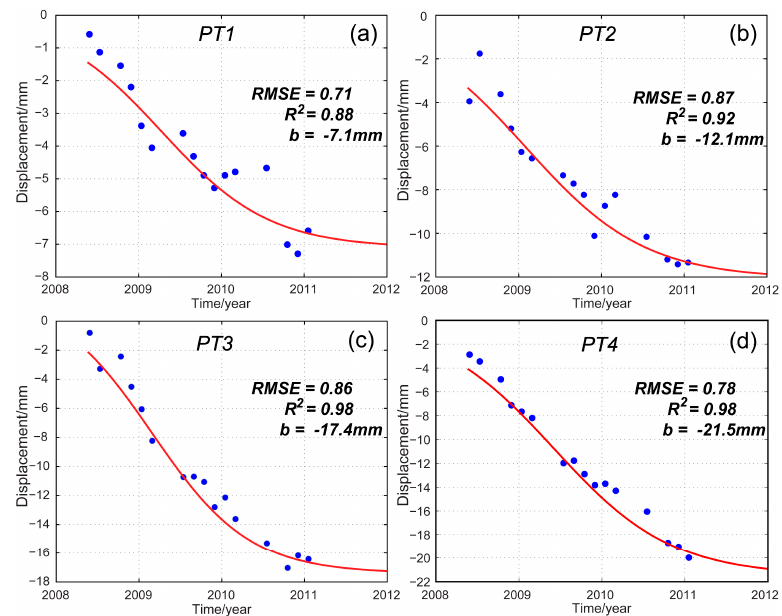
Figure 11. Fitting results of the dynamic variation of four PTs based on the logistic time model: ( a